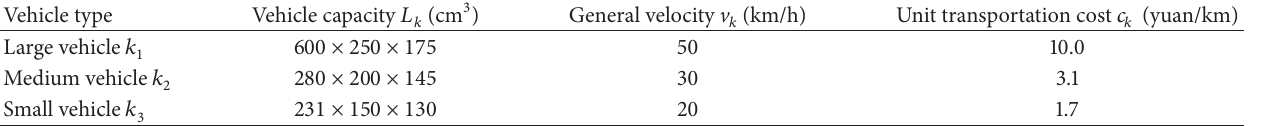
Table 2: Vehicle parameters.